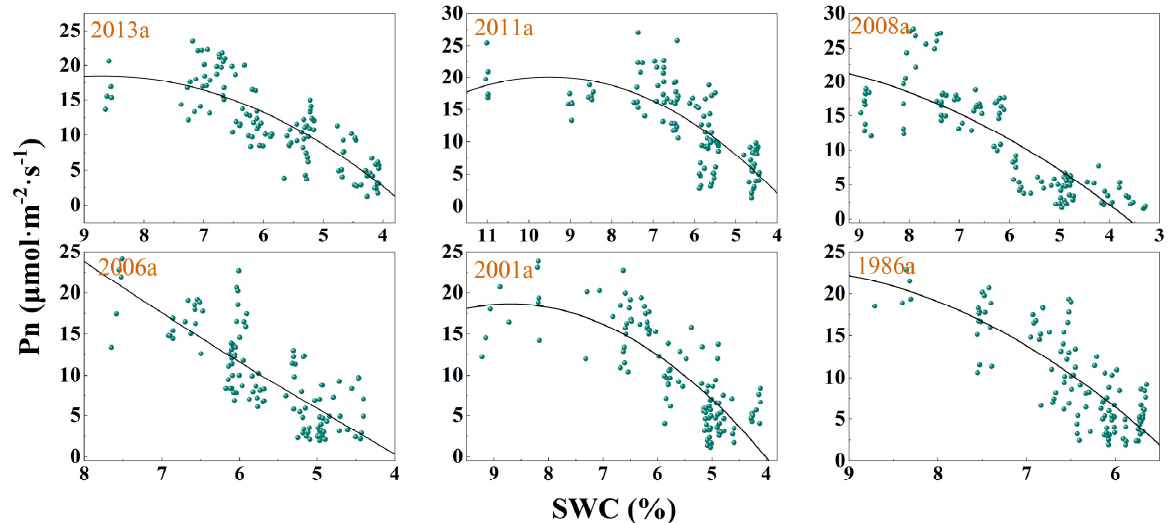
Figure 3. Regression fi tt ing diagram of Pn and SWC.